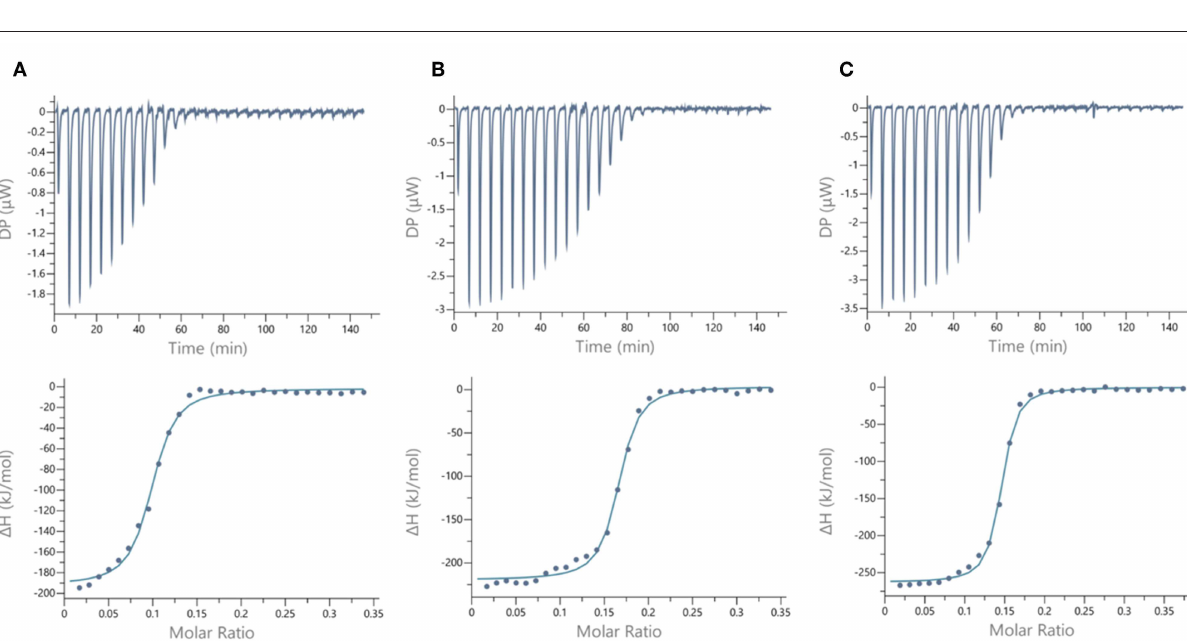
FIGURE 5 | ITC data. Thermograms obtained by injections of (A) glycodendrimer 11 at 50 µ M in a solution of LecB (32 µ M), (B) glycodendrimer 11 (50 µ M) in a solution of LecA (32 µ M), and (C) glycodendrimer 14 (40 µ M) in a solution of LecA (29 µ M) with corresponding integrated titration curves. Molar ratio is indicated as number of glycocluster molecules per lectin